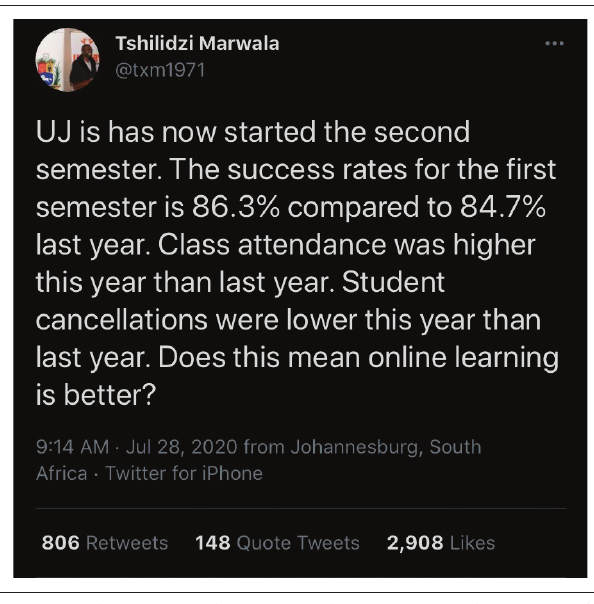
FIGURE 1: University of Johannesburg’s vice chancellor using social media, Twitter, to communicate COVID-19 learning and teaching successes with students, staff and the general public to generate open